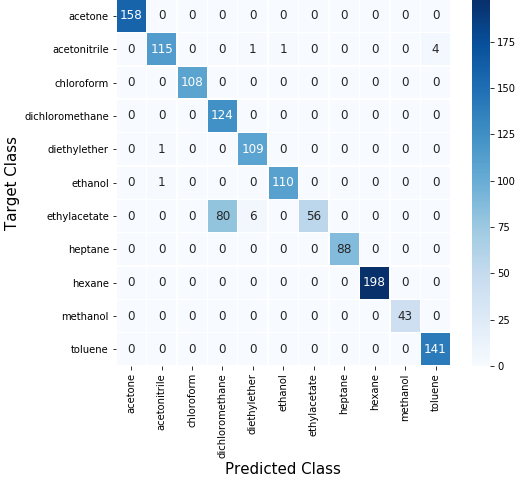
Figure 9. Confusion matrix for CNN2D+LSTM ensemble. Values in the diagonal represent correct predictions and off diagonal values represent incorrect predictions.